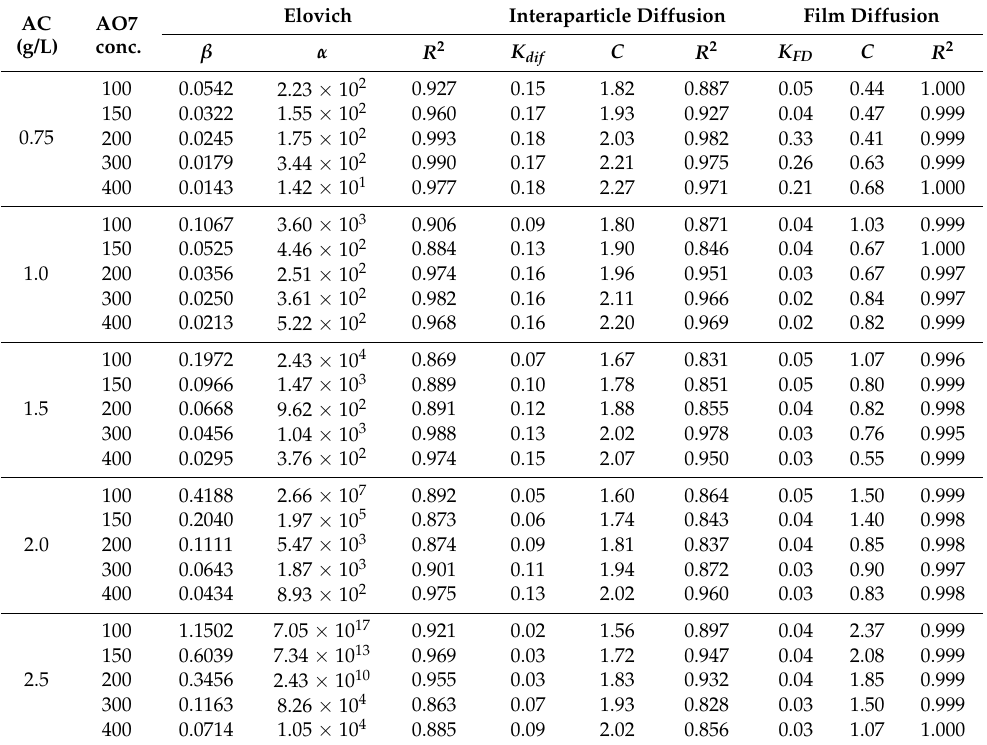
Table 4. The results of Elovich, intraparticle diffusion, and film diffusion kinetic models used to predict the adsorption of AO7 dye (100–400 mg/L) onto pea pod activated carbon produced at 800 ◦ C carbonization temperature under CO 2 using ZnCl 2 as the activating agent.